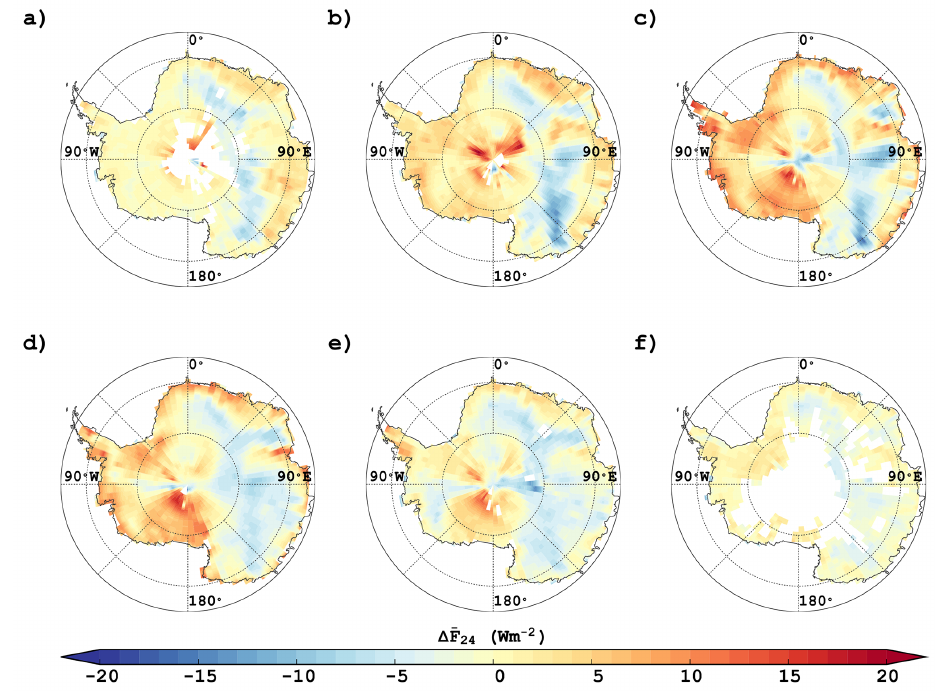
Figure 10. Difference in clear-sky ¯ F 24 (Wm − 2 ) between CS15 and KL05 ADMs for (a) – (f) October–March of 2002. Difference is calculated − ¯ F KL 05 as (cid:49) ¯ F 24 = ¯ F CS 15 24 24